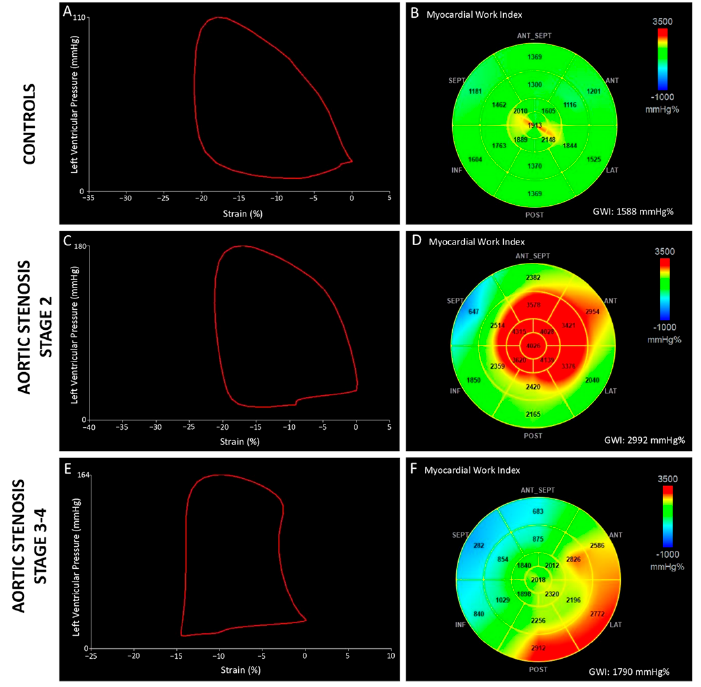
Figure 1. Pressure-strain loops ( left panels ) and 17-segment bull’s-eye representation of GWI ( right panels ) in a healthy subject ( A , B ) and in two patients with severe aortic stenosis ( C – F ). Compared to the control patient, aortic stenosis patient in stage 2 of cardiac damage ( C , D ) presented a larger pressure–strain loop, from which higher value of GWI has been estimated. Conversely, in advanced stage of aortic stenosis ( E , F ), GWI reduction reflected a more impaired LV contractile